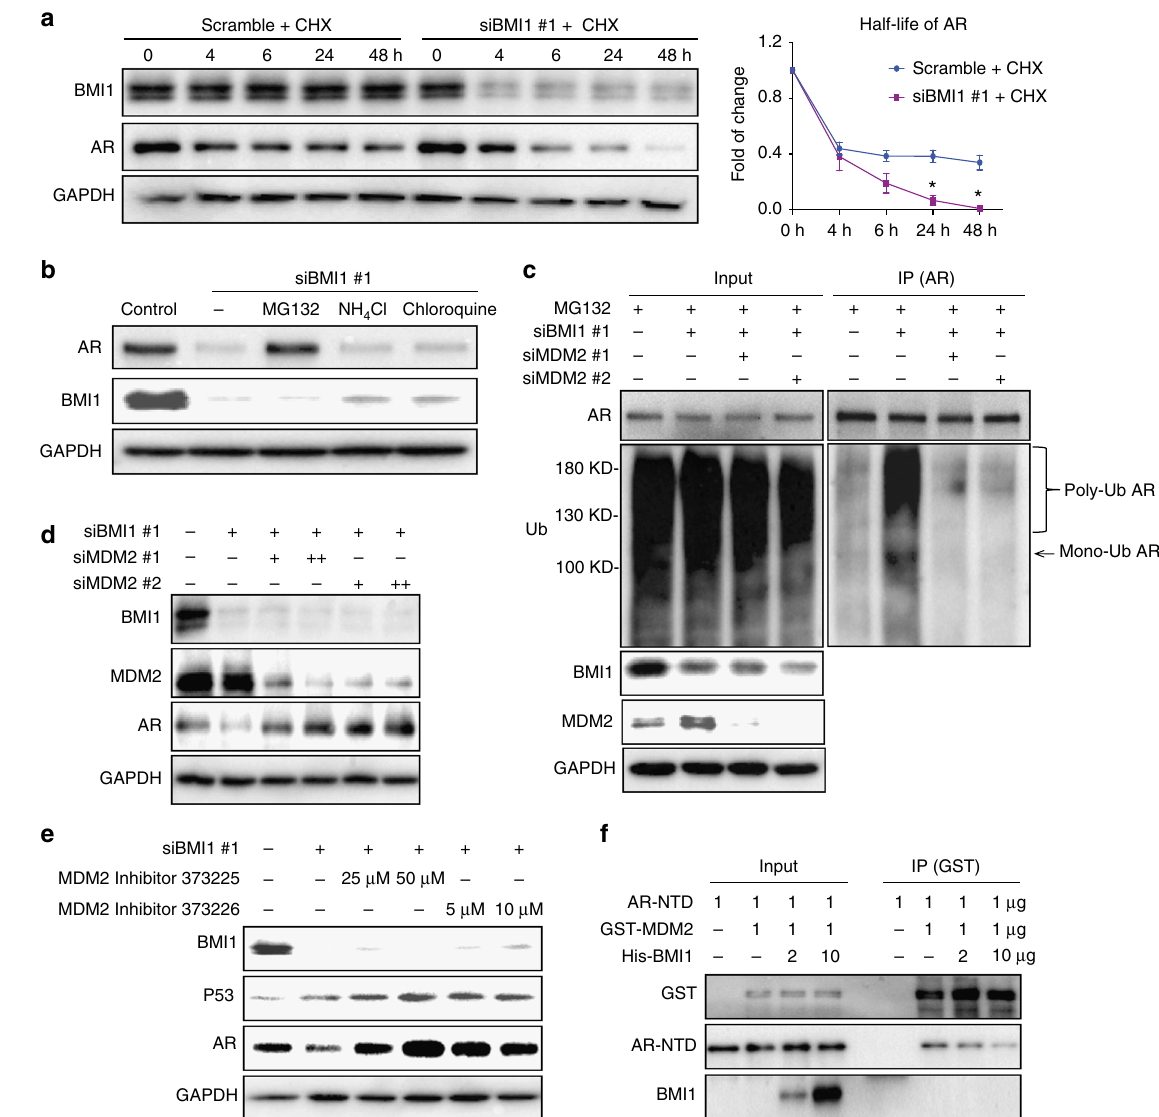
Fig. 2 BMI1 stabilizes AR via competitive inhibition of MDM2-mediated ubiquitination. a C4-2 cells were transfected with siBMI1 or scramble and at 24 h post transfection, cells were treated with 10 µ g ml − 1 CHX for the time indicated. Total cell lysates were blotted for BMI1 and AR, while GAPDH served